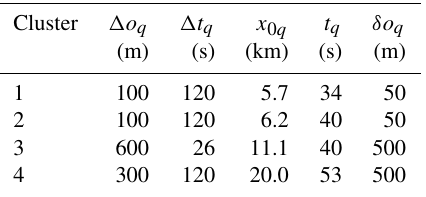
Table 2. Parameters of aerosol clusters: the simulation of the